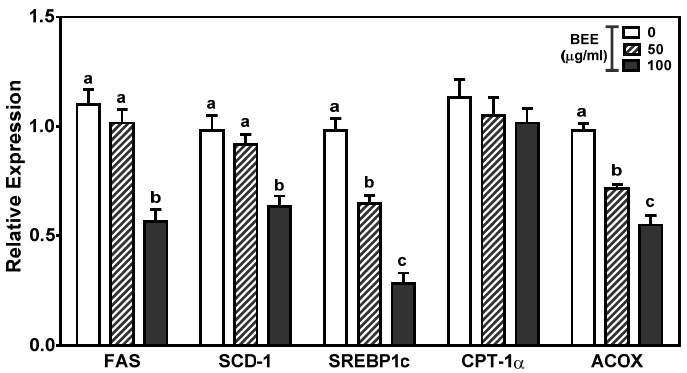
Figure 5. The effect of BEE on fatty-acid metabolism in Caco-2 cells. Cells were treated with 50 or 100 μ g/mL BEE for 24 h. The expression of genes involved in fatty-acid metabolism was measured by qRT-PCR. Data are expressed as relative expressions of control. Bars with different letters are significantly different ( p < 0.05). Values are means ± SEM; n = 6.